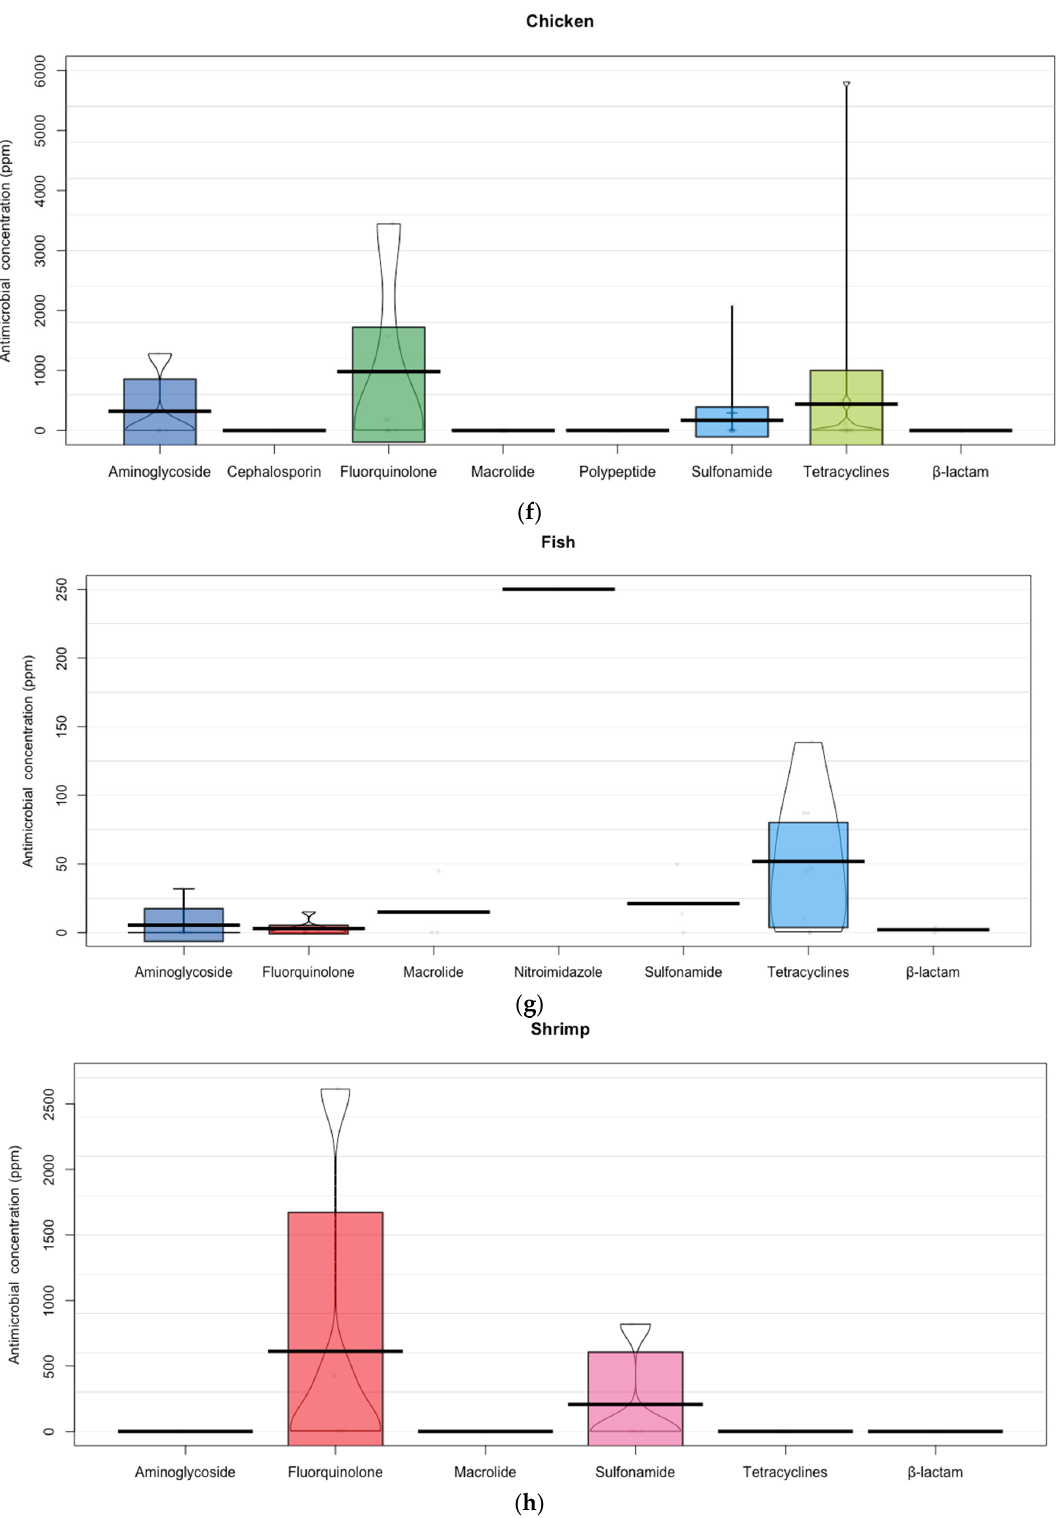
Figure 4. Presence of antibiotics in animal products according with the antimicrobial family. ( a ) Presence of antibiotics in Pork meat according with the antimicrobial family. Points represent the raw data; bar/line is the descriptive statistic (mean); bean is the smoothed density curve showing the full data distribution; and brackets represent the confidence intervals. ( b ) Presence of antibiotics in Beef meat according with the antimicrobial family. Points represent the raw data; bar/line is the descriptive statistic (mean);